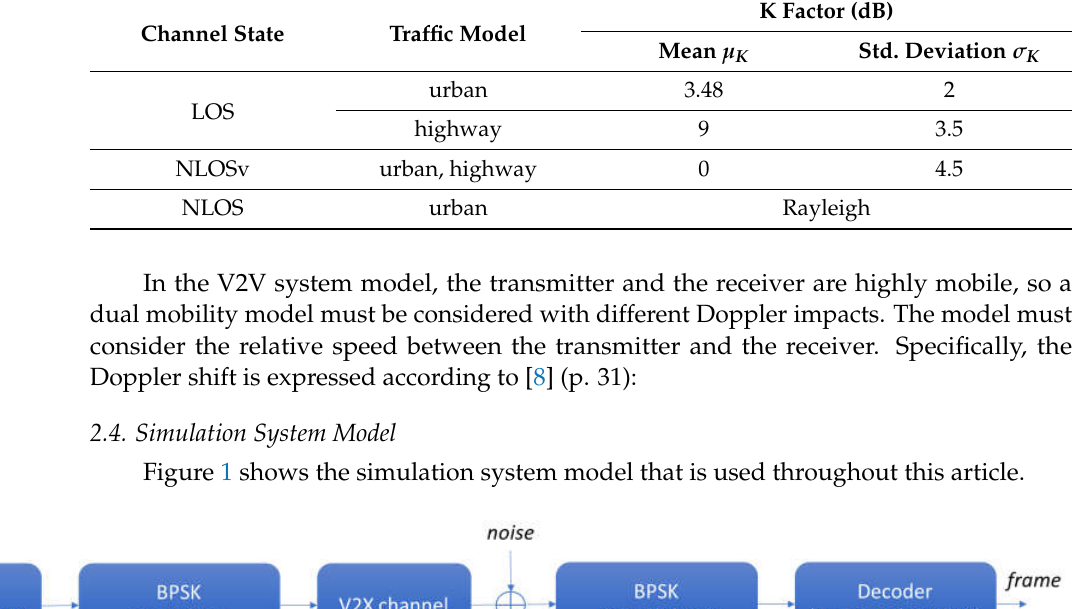
Table 5. K-factor distribution parameters for LOS, NLOSv and NLOS states [7,8]. Channel State